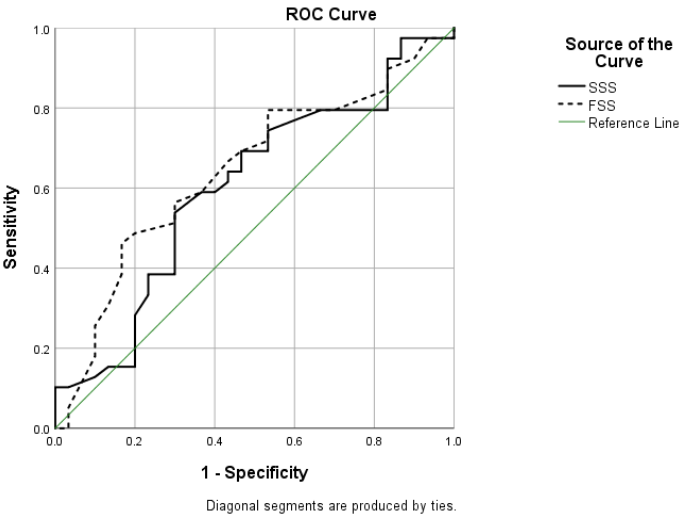
Figure 3. Receiver operating characteristic ( ROC )curve for the prediction of a high electrophysio- logical grading (EG) for symptom severity subscale (SSS) and functional status subscale (FSS) of Boston Carpal Tunnel Questionnaire Serbian Version (BCTQ SR ) on the test. The intercorrelation of the BCTQ SR subscales (SSS and FSS) on the test was significant ( p < 0.001), with a correlation coefficient equal to 0.777. There was a significant correlation between the SSS items on the test, except for the correlations between SSS Item 6 and SSS Item 2 (r = 0.192; p = 0.114), SSS Item 6 and SSS Item 4 (r = 0.189; p = 0.121), SSS Item 6 and SSS Item 5 (r = 0.062; p = 0.610), SSS Item 8 and SSS Item 5 (r = 0.216; p = 0.074) and SSS Item 10 and SSS Item 5 (r = 0.184; p = 0.131). The highest correlation was between Item 5 and Item 4 (r = 0.858; p < 0.001) and the lowest correlation was between Item 6 and Item 5 (r = 0.062; p = 0.610) (Table 4). Table 4. Correlations between SSS items on the test. Correlations